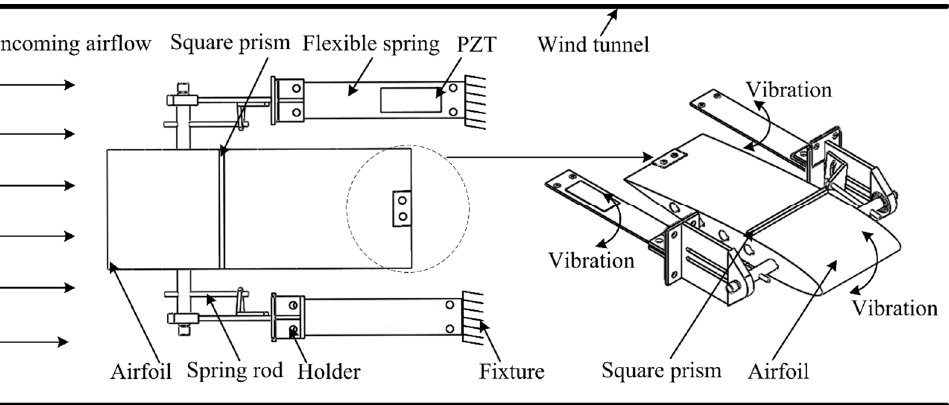
Figure 1. Schematic of a piezoelectric energy harvester.